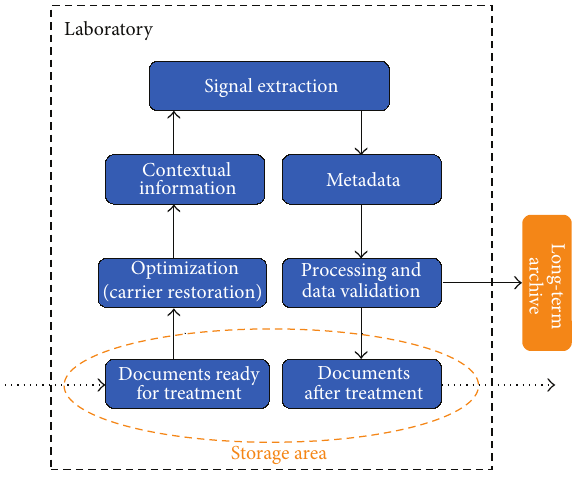
Figure 9: Abstract view of the activities that take place in the preservation